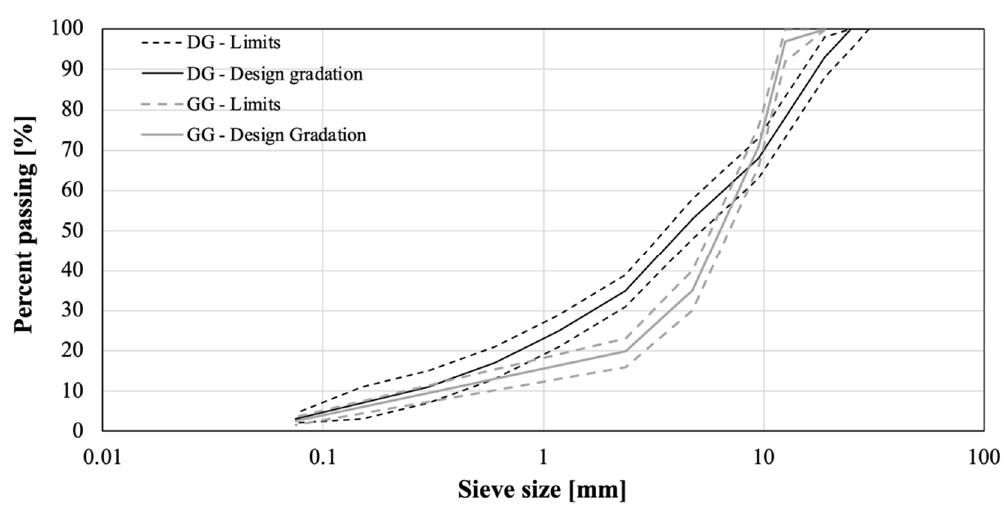
Figure 3. Aggregate gradation and limits. Table 2. Volumetric and mechanical Characteristics at the Mix-design Level.